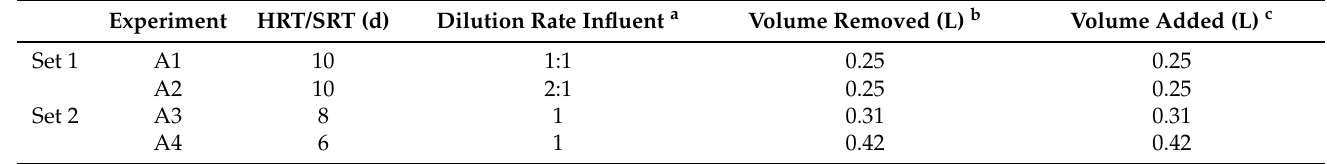
Table 1. Operational characteristics of four photobioreactors treating municipal wastewater under semi-continuous regime used in the experimental setup.